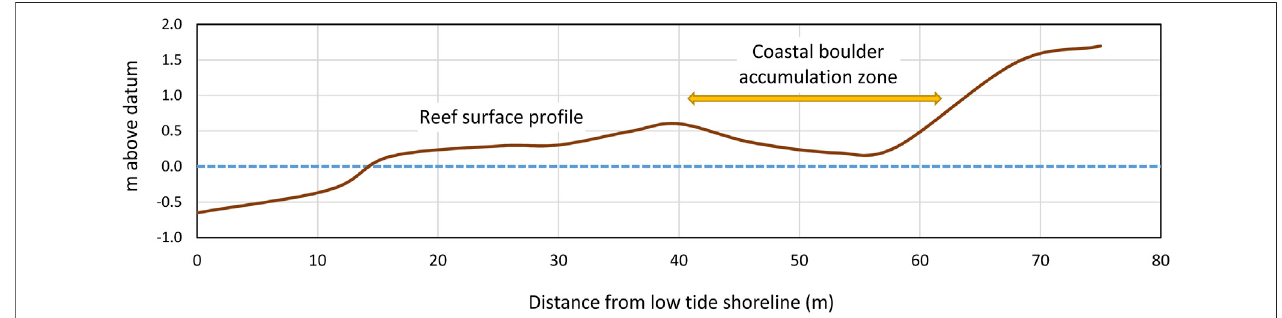
FIGURE 8 | Surveyed reef-platform surface topography (see Figure 3A for transect location). Note the back-reef depression that acted as the main accumulation zone for the wave-deposited cluster of stacked and imbricated clasts ( Figure 8 ).